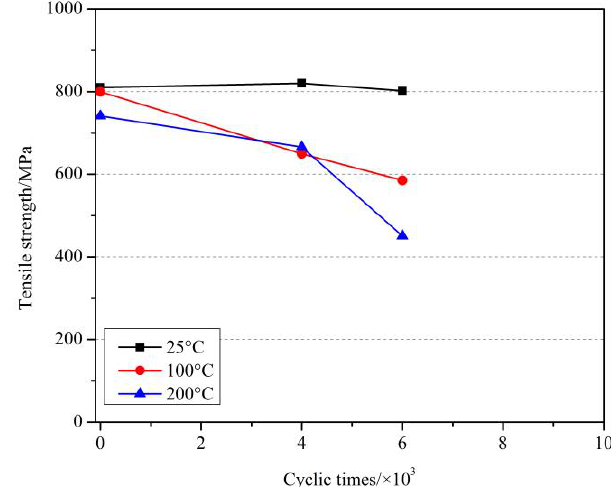
Figure 8. The effect of cyclic load on the tensile strength of GFRP bars after elevated temperatures with a holding time of 2 h.